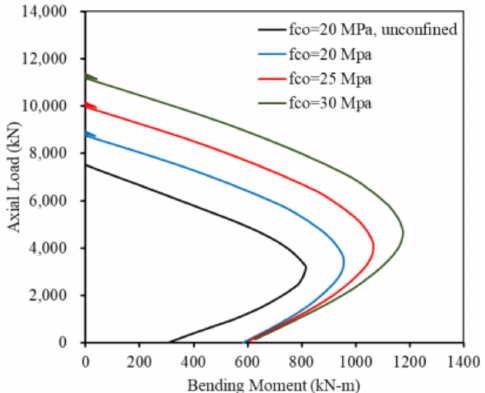
Figure 21. P-M interaction curves according to the concrete strength (S-C cross-section).